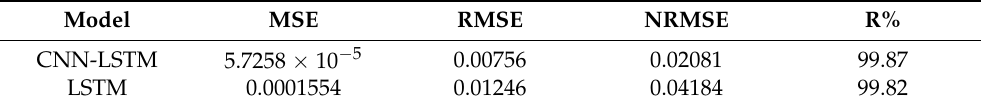
Figure 9. Histogram of deep learning models ( a ) CNN-LSTM and ( b ) LSTM for predicting the Tesla stock market closing price during the testing phase.